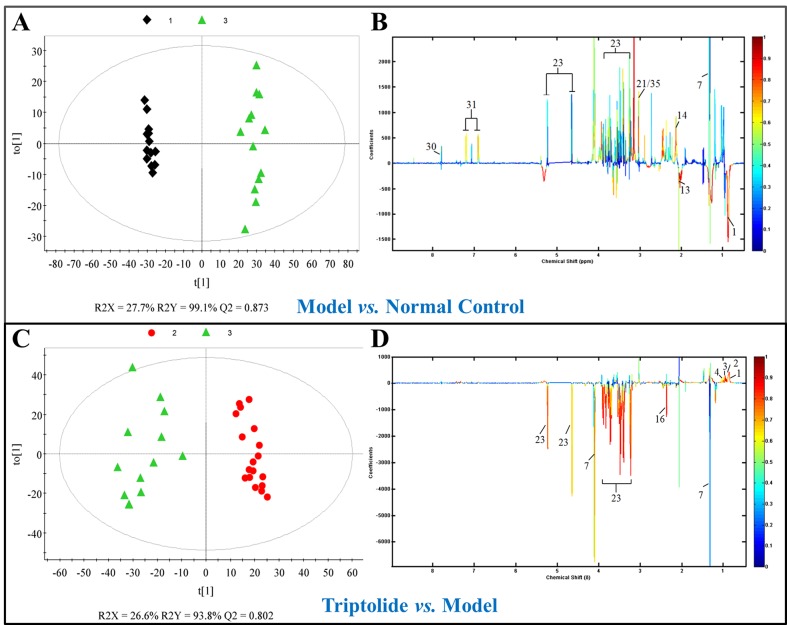
(A, C) OPLS-DA score plots and (B, D) efficient loading plots derived from the 1H NMR spectra of plasma from normal control, model, and triptolide-treated groups. Color-coding corresponds to the correlation coefficients of the metabolic variables.